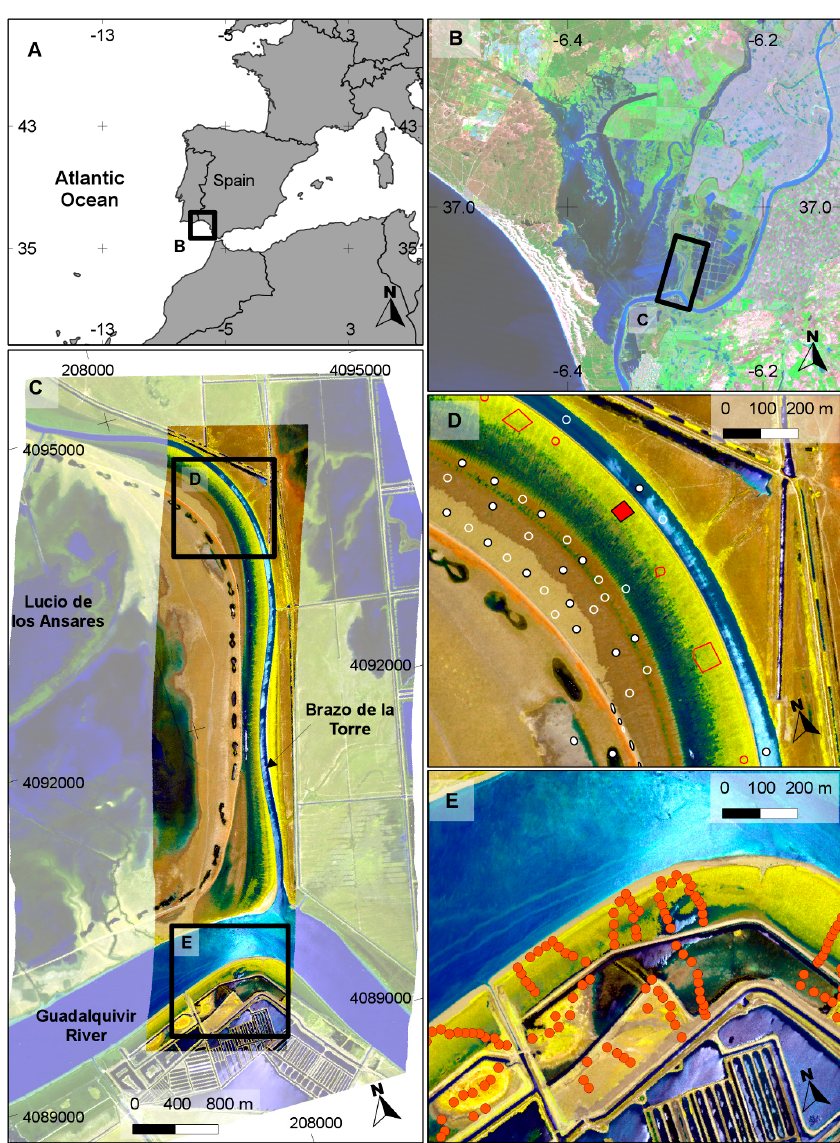
Figure 1. ( A ) Location of Doñana National Park in southwestern Spain. ( B ) Location of the airborne campaign on the eastern side of Doñana marshes. Background Landsat TM image of 25 February 2011. ( C ) Extent of the study area (763 ha) is delimited by the false color composite of the CASI-1500 image (RGB = 861.6, 650.8, 550.1 nm) overlaid on top of the AHS image (background). ( D ) Zoom to an example of a few target ( Spartina densiflora ) (red) and background (white) polygons overlaid on the CASI image. Solid polygons correspond to training sites and hollow polygons to test sites used for model validation. ( E ) Location of sampling points at the evaluation site of “Codo de la Esparraguera” overlaid on the CASI image. Map projections: ETRS89/UTM Zone 30 N. Map grids: ( A ) and ( B ) in decimal degrees, ( C ) UTM in m.